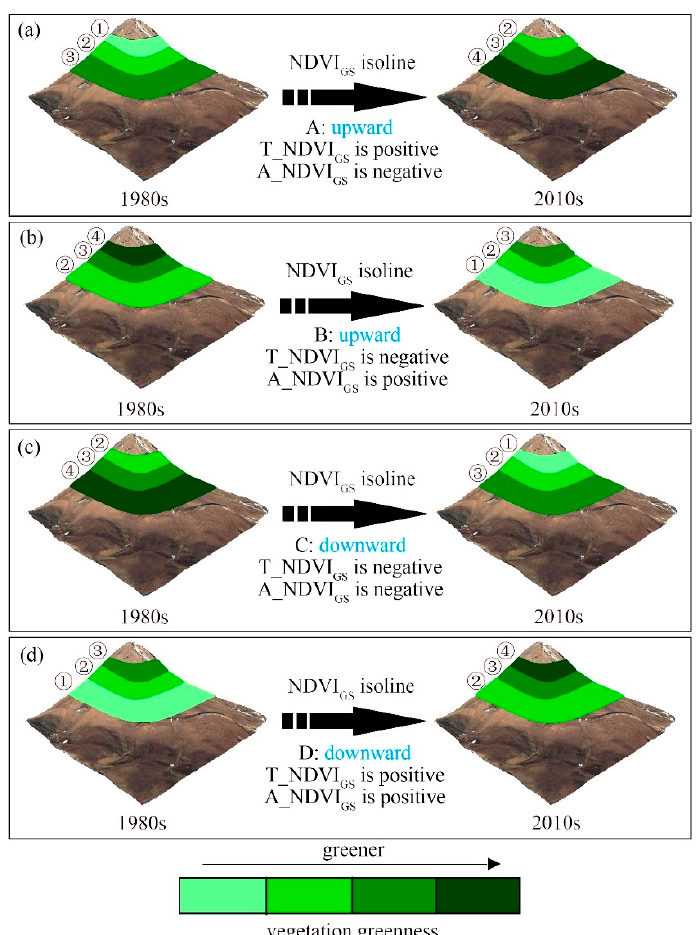
Figure 1. Illustration for the elevational movement of the NDVI GS isolines. Upward movement of the NDVI GS isolines, including A mode: the interannual variation trend of NDVI GS isolines is positive and the altitudinal gradient is negative ( a ), and B mode: the interannual variation trend is negative and the altitudinal gradient is positive ( b ). Downward movement of the NDVI GS isolines, both the interannual variation trend of NDVI GS isolines and the altitudinal gradient are negative (C mode, ( c )) or positive (D mode, ( d )).